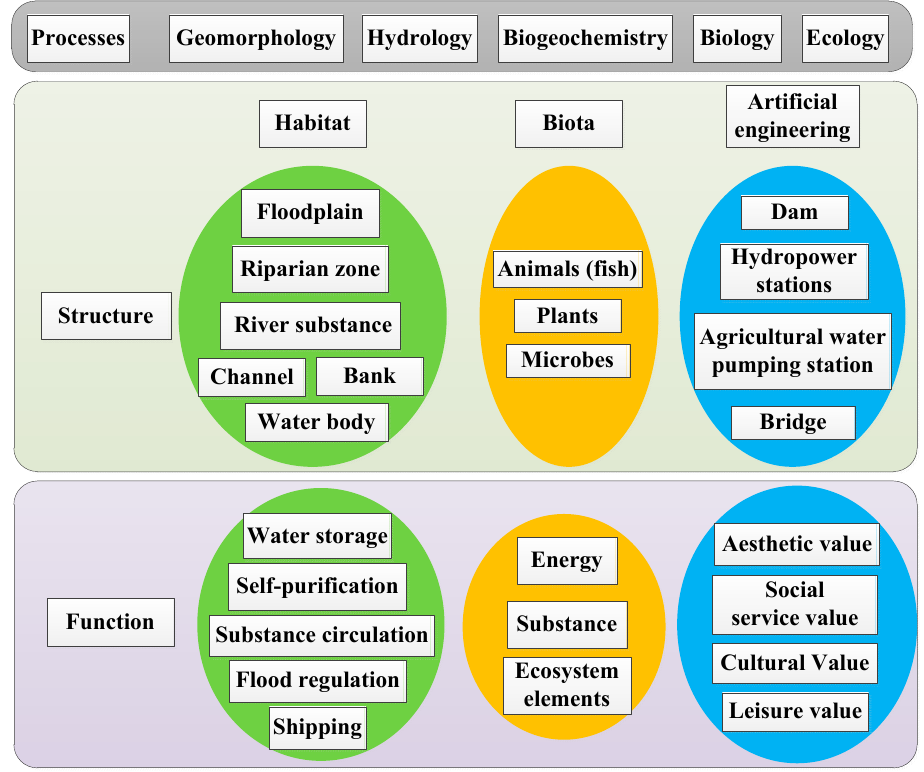
Figure 1. Processes, structures, and functions of the river. Processes are associated with physical, chemical, and biological processes in the river. The structure is linked with the composition of the river. The function is the use the river provides for human beings or society.